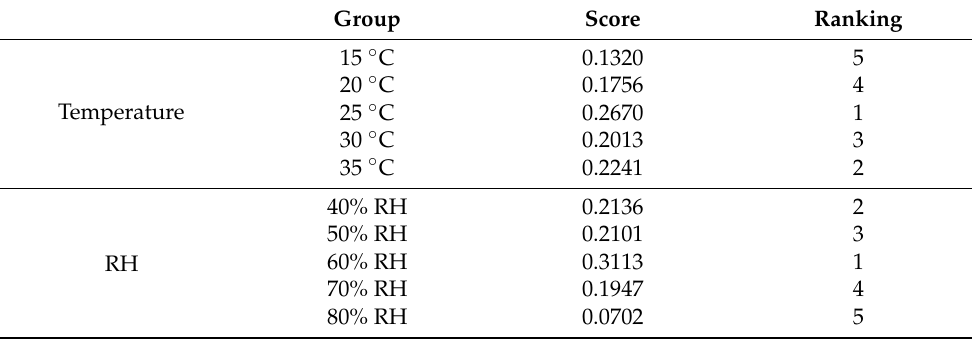
Table 2. The evaluation results of the TOPSIS method under different storage conditions. Group